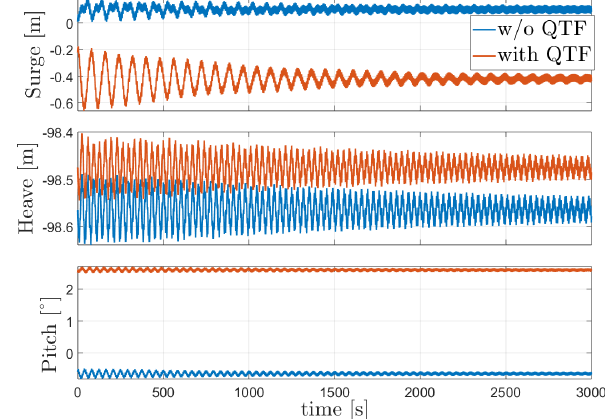
Figure 8. WindCrete response to regular waves at CG ( T = 6s ,H =